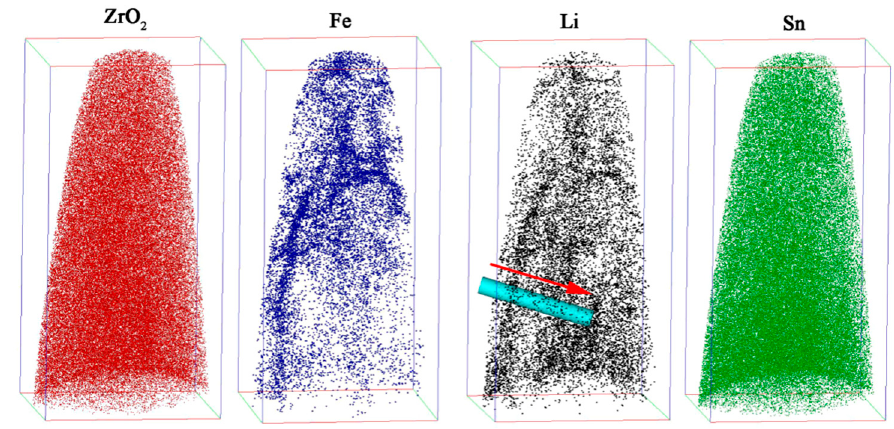
Figure 4. The distributions of ZrO 2 ( red ), Fe ( blue ), Li ( black ) and Sn ( green ) in the needle-shaped specimen prepared in the oxide formed on the S N surface of the Zircaloy-4 specimen corroded in lithiated water with 0.01 M LiOH at 633 K/18.6 MPa for 70 d exposure. The distance of the needle-shaped specimen tip apart from the O/M interface was about 1 µm. The size of the maps showing the atom distribution was 100 × 98 × 202 nm 3 . The analysis cylinder (10 nm in diameter) is signed in the graph, and the arrow indicates the analysis direction for Figure 5.